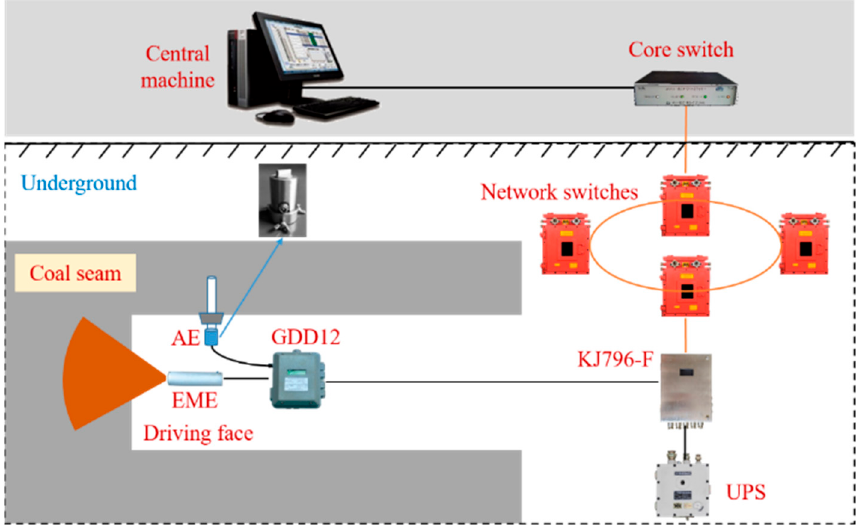
Figure 2. AE and EMR monitoring system and sensors